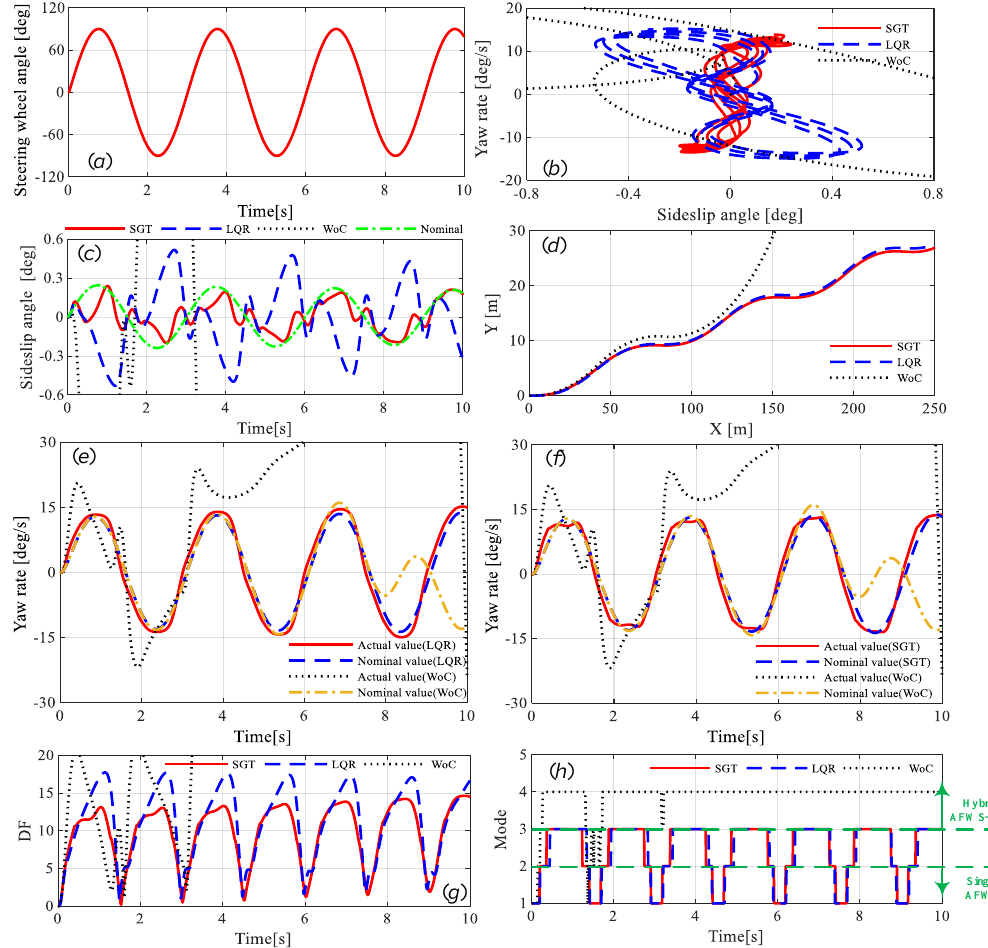
Figure 7. Steering input and dynamic responses of open-loop sinusoidal steering test at 100 km / h. ( a ) Sinusoidal steering wheel angle; ( b ) β - ω phase portraits; ( c ) sideslip angle; ( d ) Y position; ( e ) yaw rate of LQR. ( f ) yaw rate of SGT; ( g ) dangerous factor (DF); ( h ) working mode.